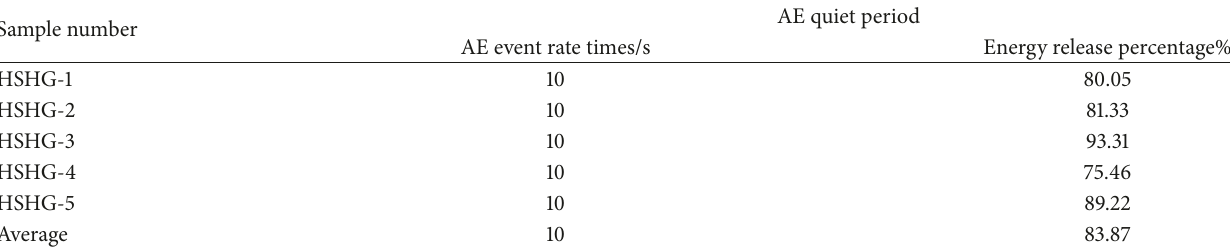
Table 2: Characteristic of time-domain parameters of AE quiet period of